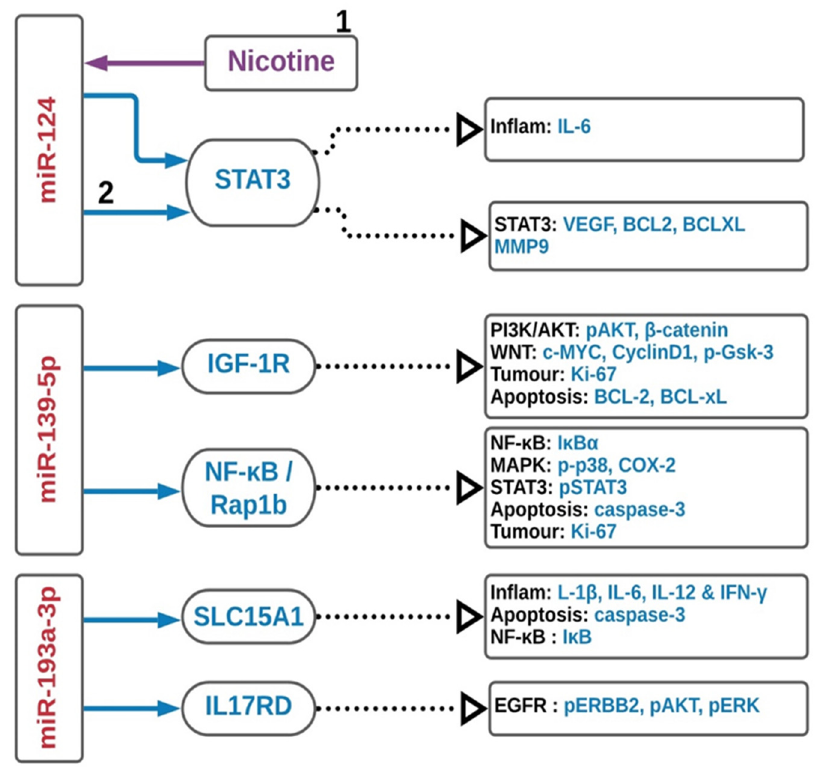
Figure 2. Downregulation of miRNAs in colitis-associated colorectal cancer. The schematic diagram summarizes the major pathways in the downregulation of miRNAs. Red, blue and purple in the diagram represent inhibition, regulation and enhancer, respectively. Inflam, inflammation.